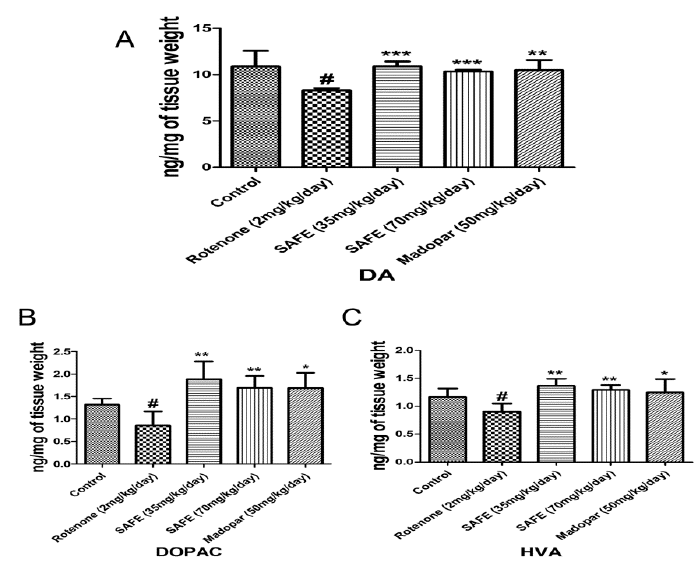
Figure 5. HPLC analysis of DA and its metabolites. Effects of SAFE on DA and its metabolites in the striatum of rotenone-induced rat model of PD. ( A ) DA levels; ( B ) DOPAC levels; ( C ) HVA levels. The parameters are presented as the mean ± SD, ( # compared to control, # p < 0.05; * compared to rotenone, * p < 0.05, ** p < 0.01, *** p < 0.001) ( n = 4).